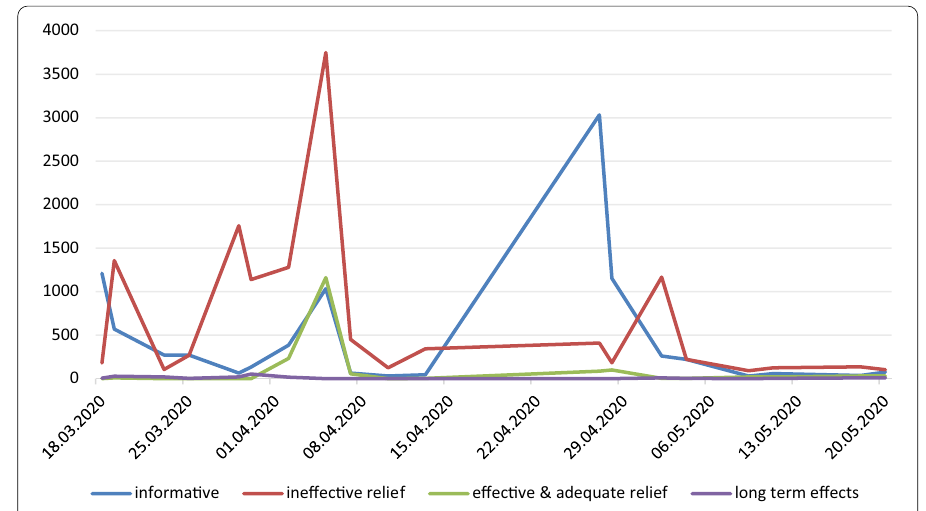
Fig. 4 Intensity of discussion on the selected